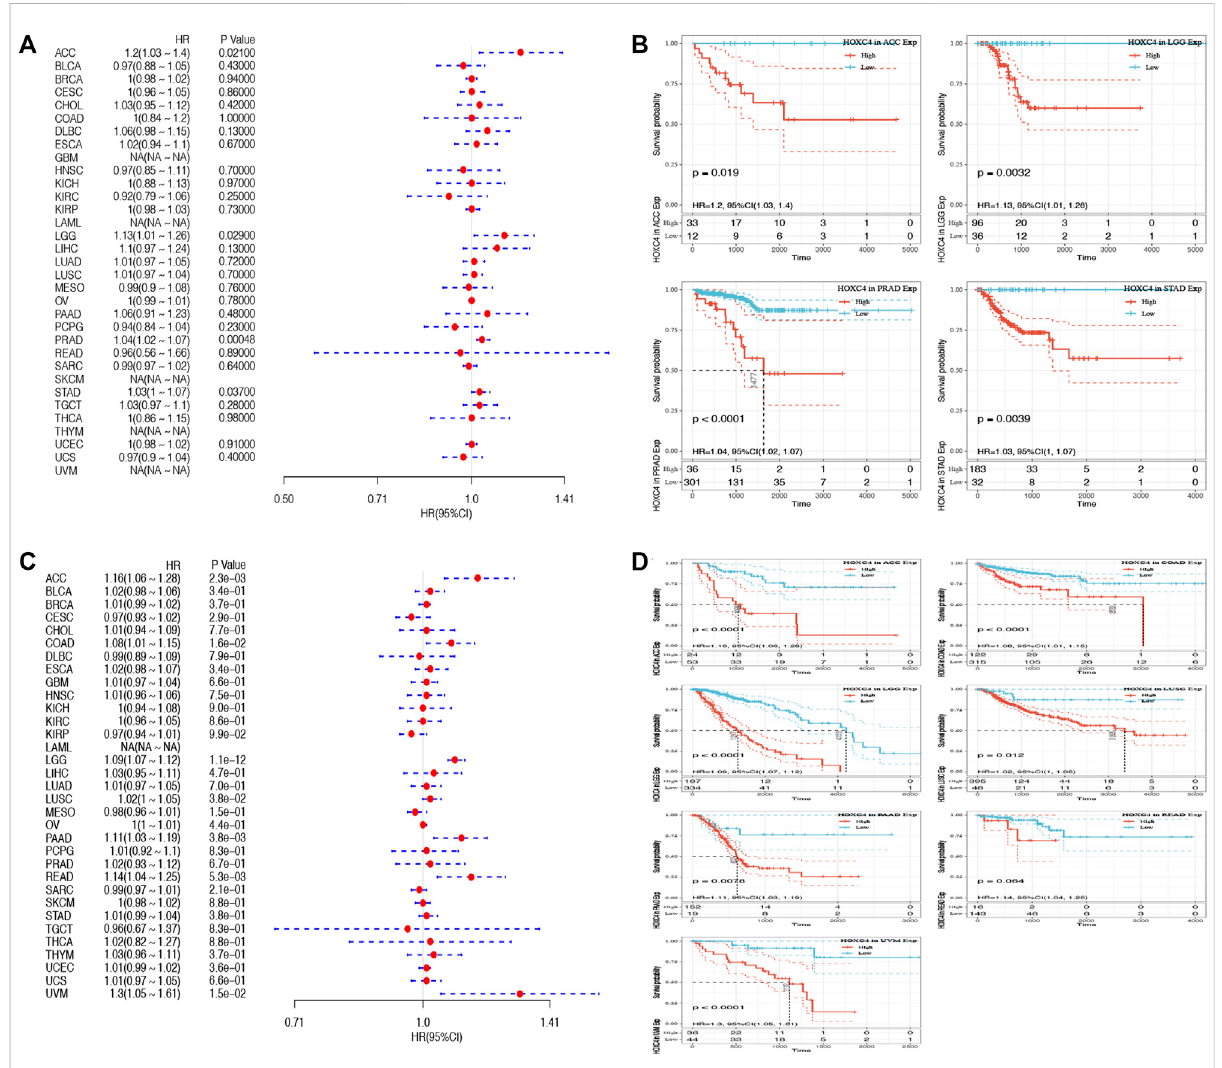
FIGURE 2 Forest plot and Kaplan-Meier curves of the relationship between HOXC4 expression and DFI and DSS in various types of tumors (A,B) HOXC4 expression is associated with DFI analysis in ACC, LGG, PRAD and STAD; (C,D) HOXC4 expression is associated with DSS analysis in ACC, COAD, LGG, LUSC, PAAD, READ and